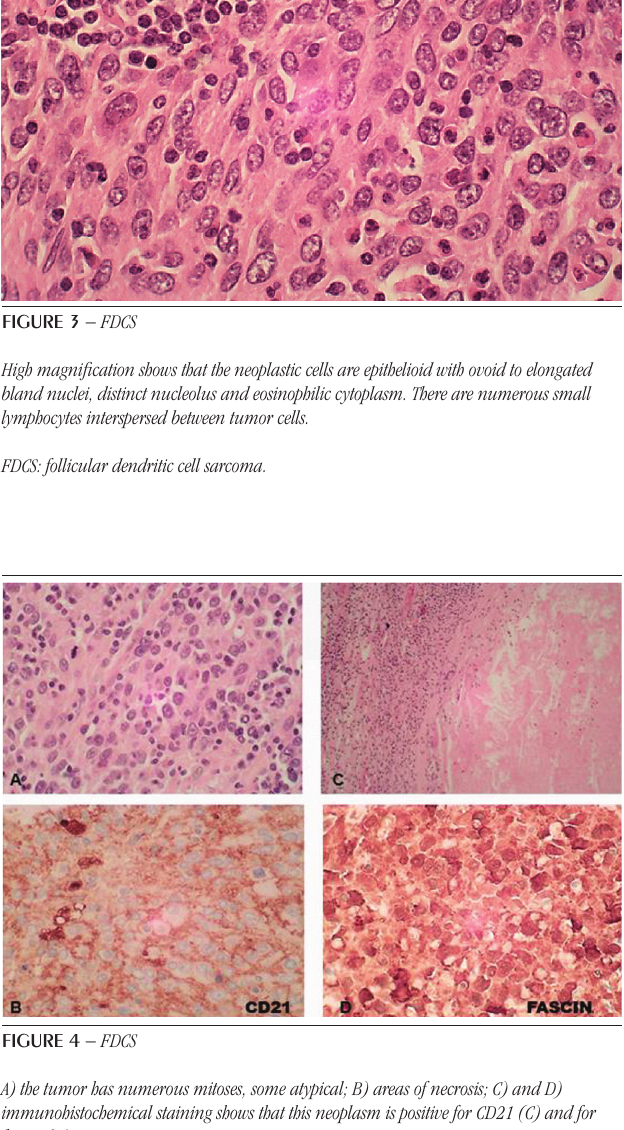
FDCS: follicular dendritic cell sarcoma;